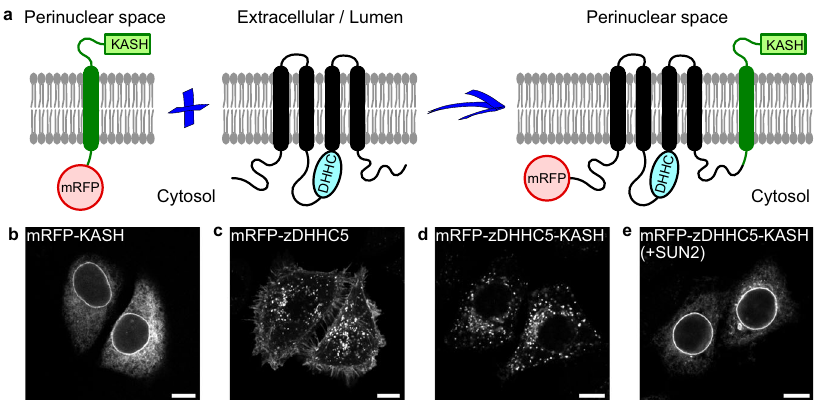
Fig. 4 Local S-palmitoylation at the ONM — the “ SwissKASH ” assay. a Schematic representation of the core components of the SwissKASH assay. b – e Representative images of HeLa cells expressing the constructs mRFP-KASH that targets the ONM ( b ), mRFP-zDHHC5 ( c ) or mRFP-zDHHC5-KASH ( d , e ) with or without the co-expression of SUN2. Note that mRFP-zDHHC5-KASH ef fi ciently targets the ONM in the presence of SUN2 ( e ). b – e Scale bars, 10